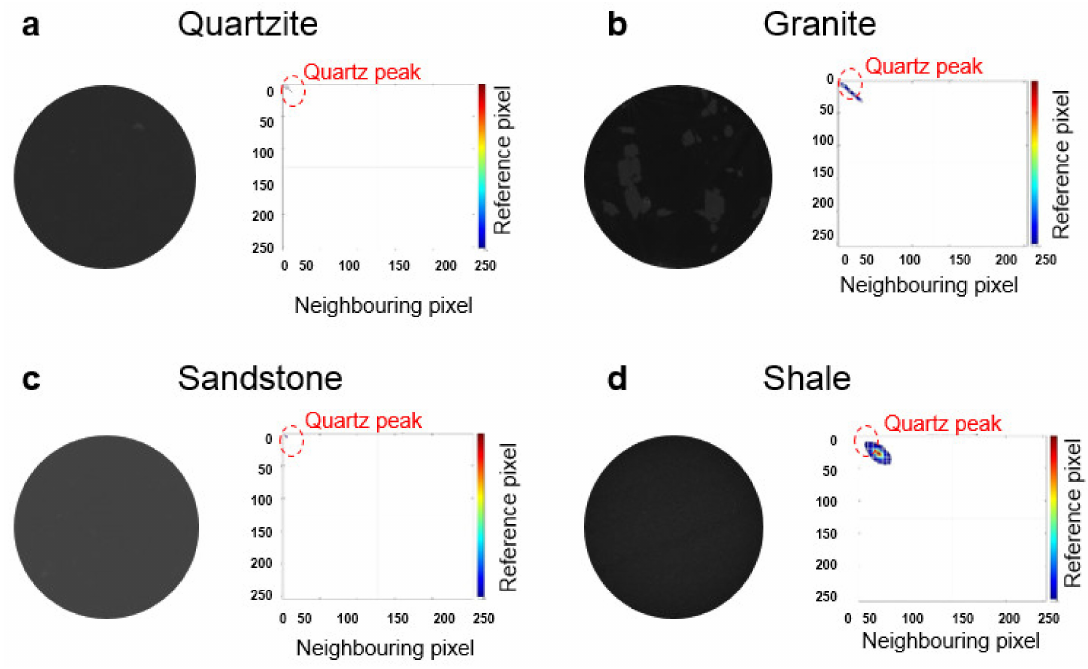
Figure 9. 2D XCT image slices and their accompanying GLCM heat maps for the homogeneous rocks, ( a ) quartzite, ( b ) granite, ( c ) sandstone and ( d ) shale. All samples were scanned using the three-point reference calibration (copper wire, air and tungsten